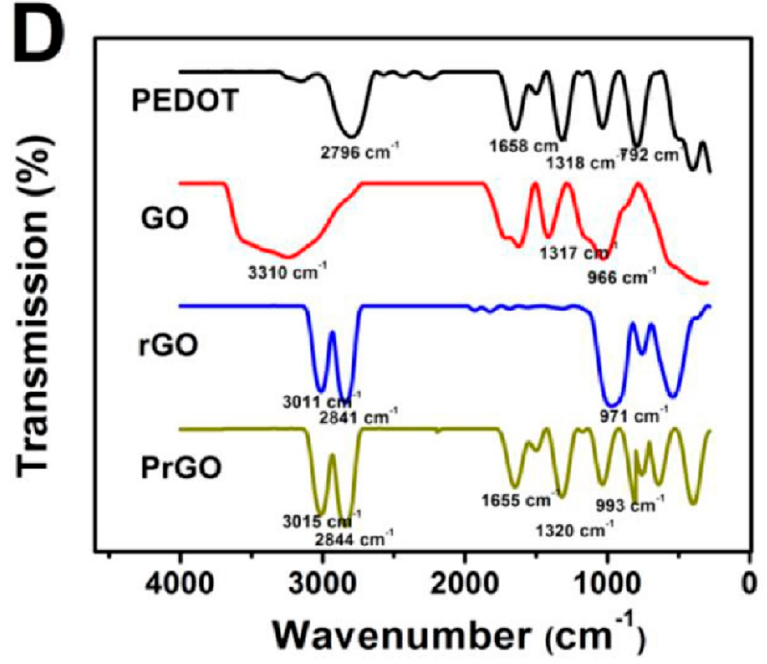
Figure 10. FTIR spectra of the compounds: PEDOT (black curve), GO (red curve), rGO (blue curve); and PrGO (dark yellow). Reproduced with permission from ref. [16]; Copyright 2022 MDPI.